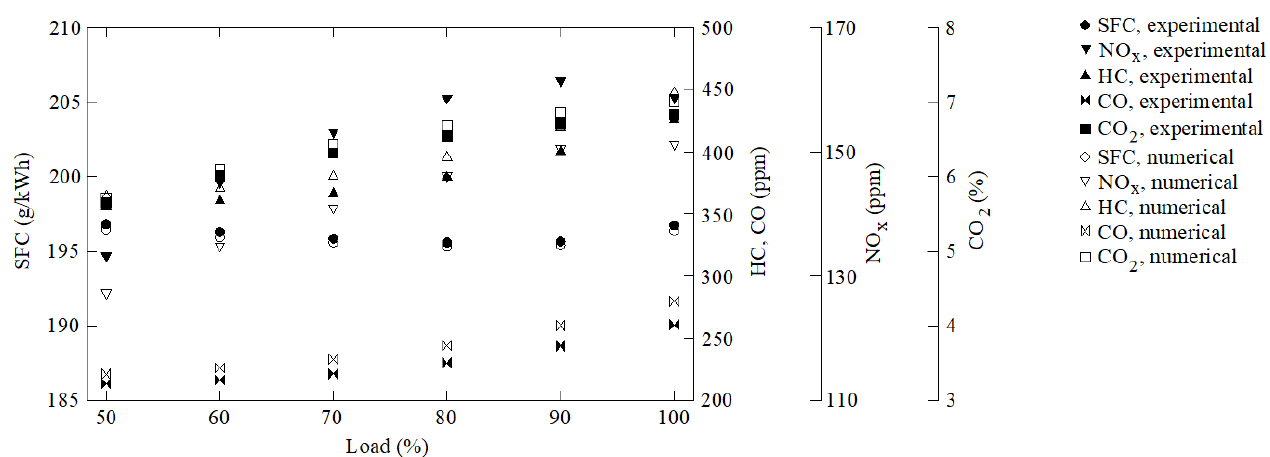
Figure 3. Emissions and